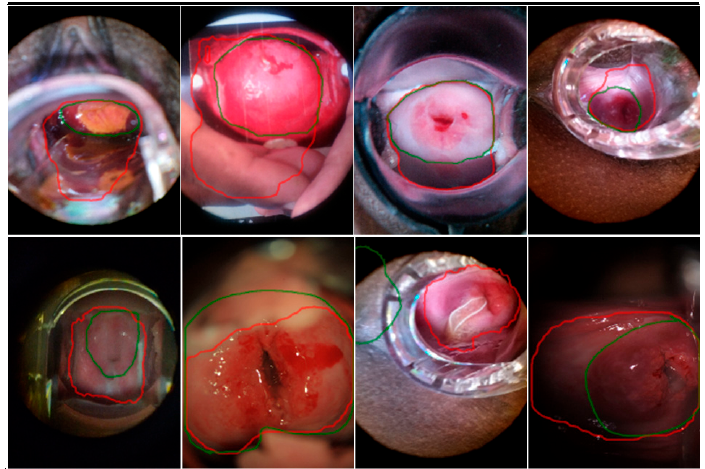
Figure 8. Tested images with Dice scores < 0.9. The green lines are the ground truth marked by human experts, red lines are model predictions.